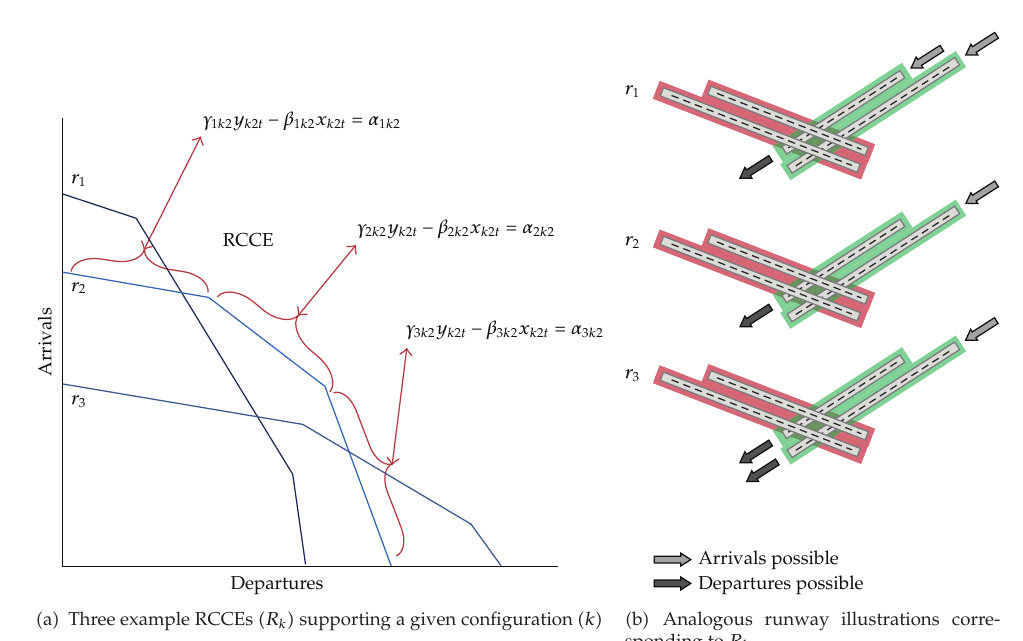
Figure 5: RCCEs supporting departure-heavy, neutral, anVd arrival-heavy runway options for a given configuration, k